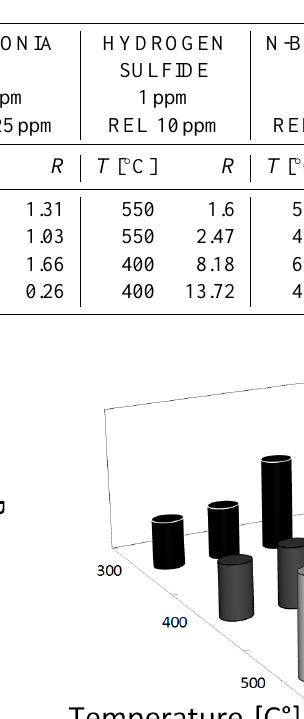
Table 2. The optimal working temperatures T best and the corresponding responses for all analyzed films tested with gases of interest and reference gas n-butanol at the same concentration of 1ppm.